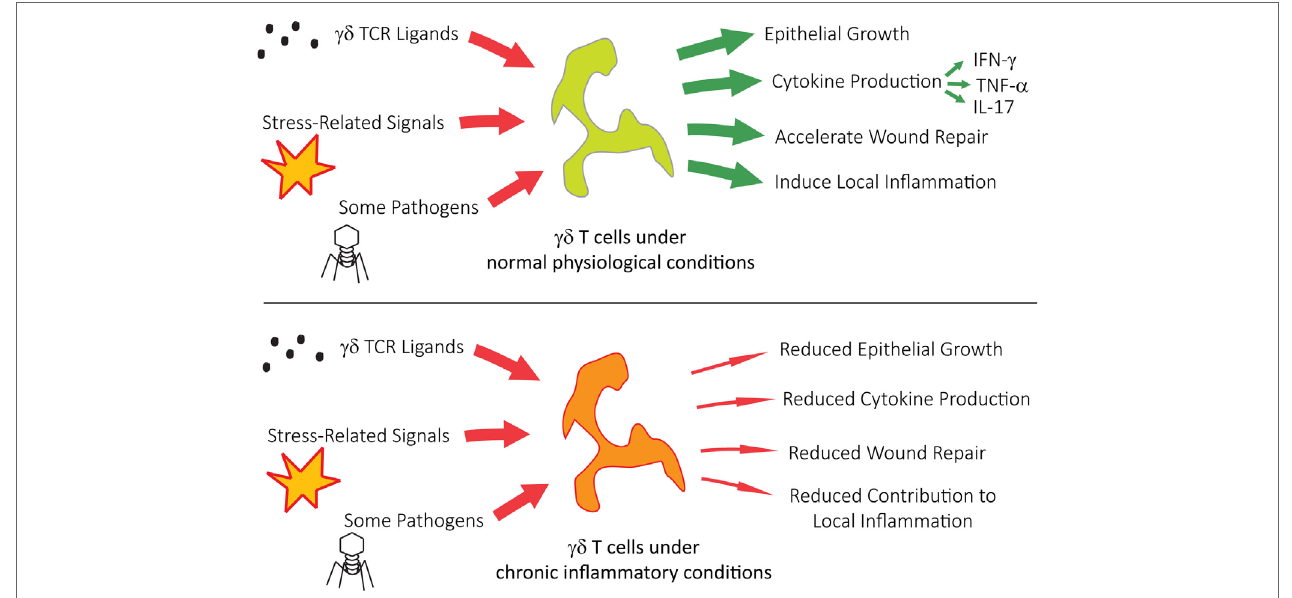
FiGURe 2 | γδ T cells under chronic inflammatory conditions show reduced activity, contributing to multiple pathophysiological issues